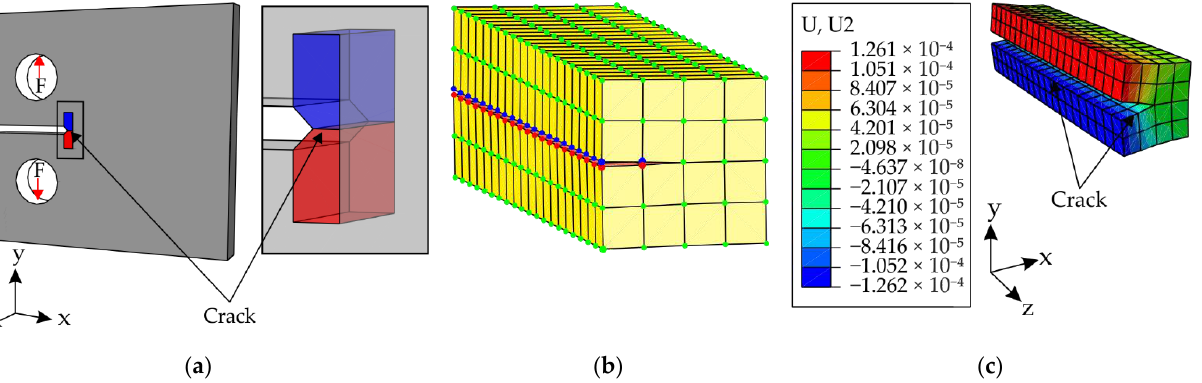
Figure 9. CT s pecimen with ‘ element s ets’ and submodel with different sets of ‘driven nodes’: ( a ) Global model of CT s pecimen with ‘ element s ets’ defined on both sides of the crack; ( b ) Submodel generated with three different sets of ‘driven nodes’ marked in red, blue , and green; ( c ) Displace- ment of the submodel in the